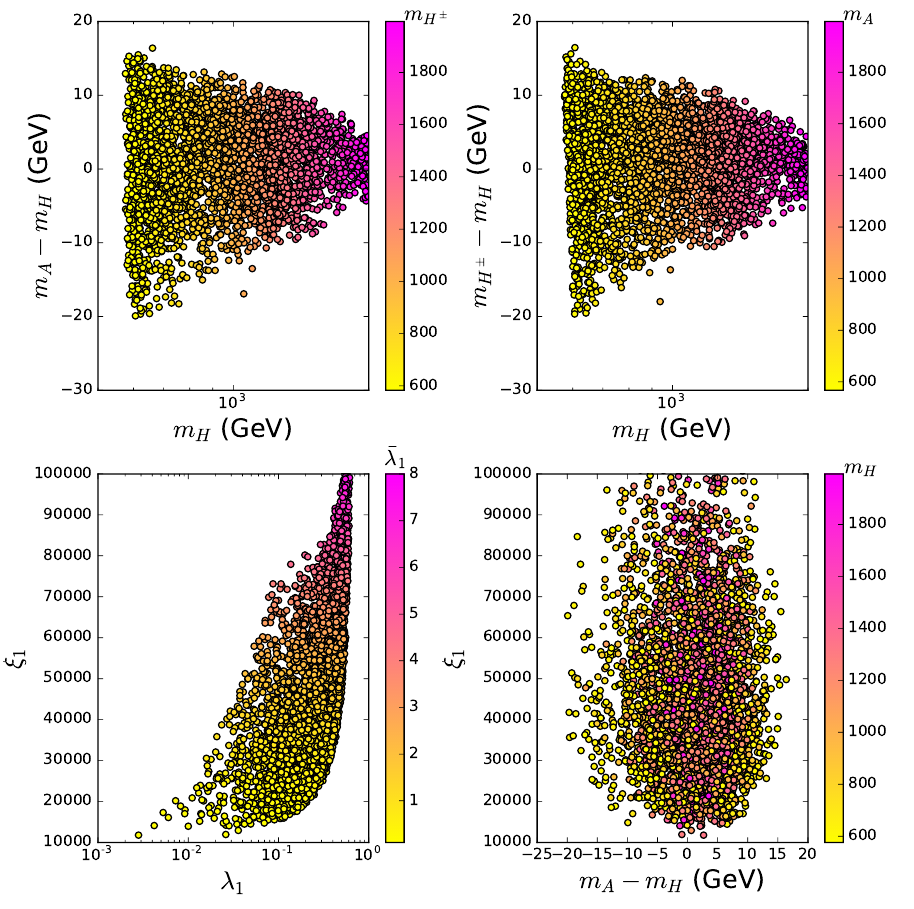
Figure 10 . In the type-II model, all the surviving samples satisfies the constraints of pre-inflation, h 1 -inflation, the exclusion limits from searches for Higgs at LEP, the flavor observables, R b , and the direct searches at the